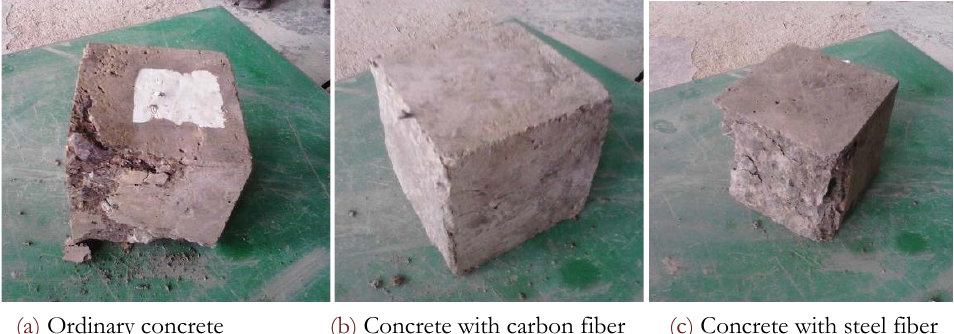
Figure 11: Damage situation of the two different test blocks after the pressure